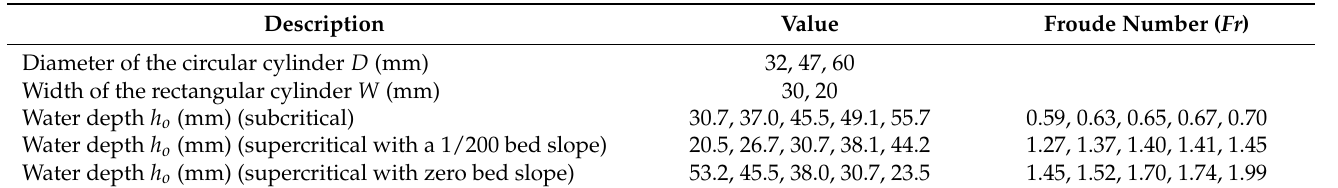
Table 1. Water depths, geometric characteristics, and Froude numbers considered in the experiment.